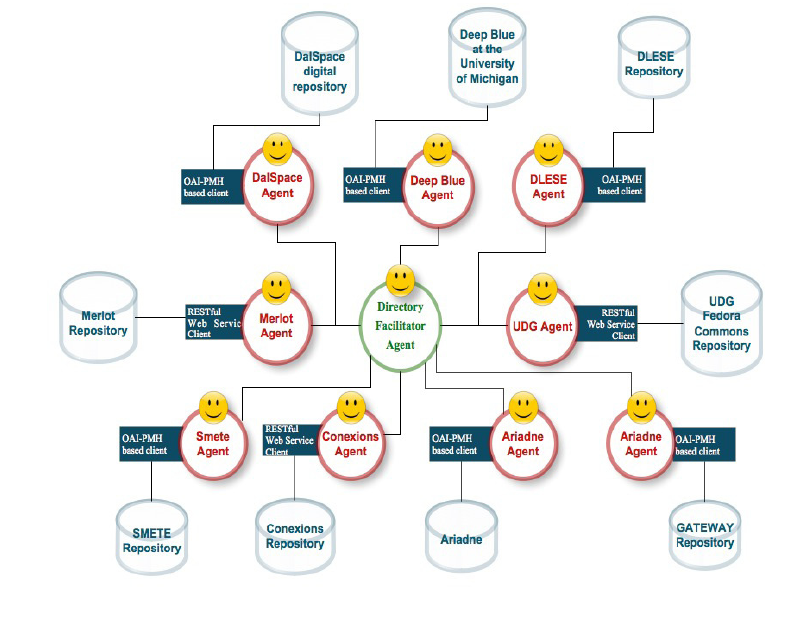
Figure 1 . LORSE Multiagent